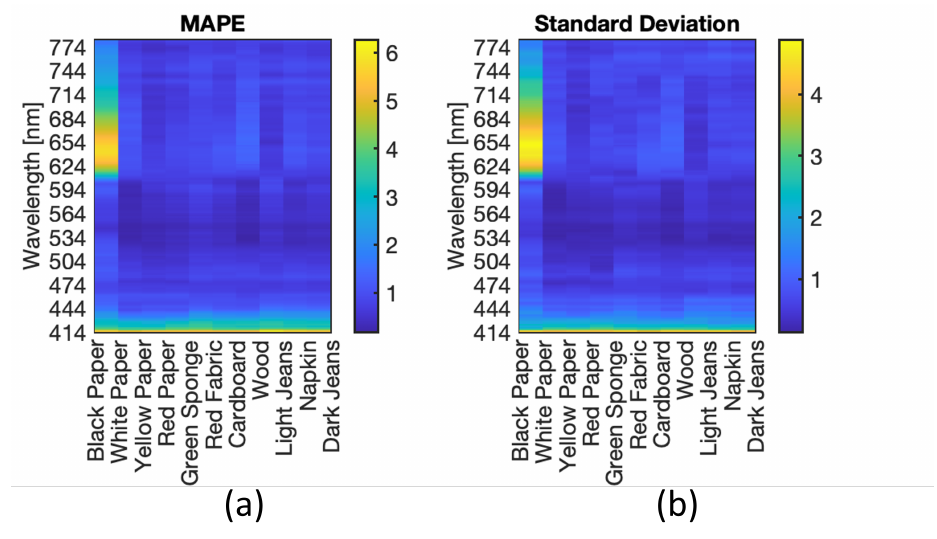
Figure 15. MAPE ( a ) and standard deviation ( b ) as functions of the different substrates and the spectral wavelengths.